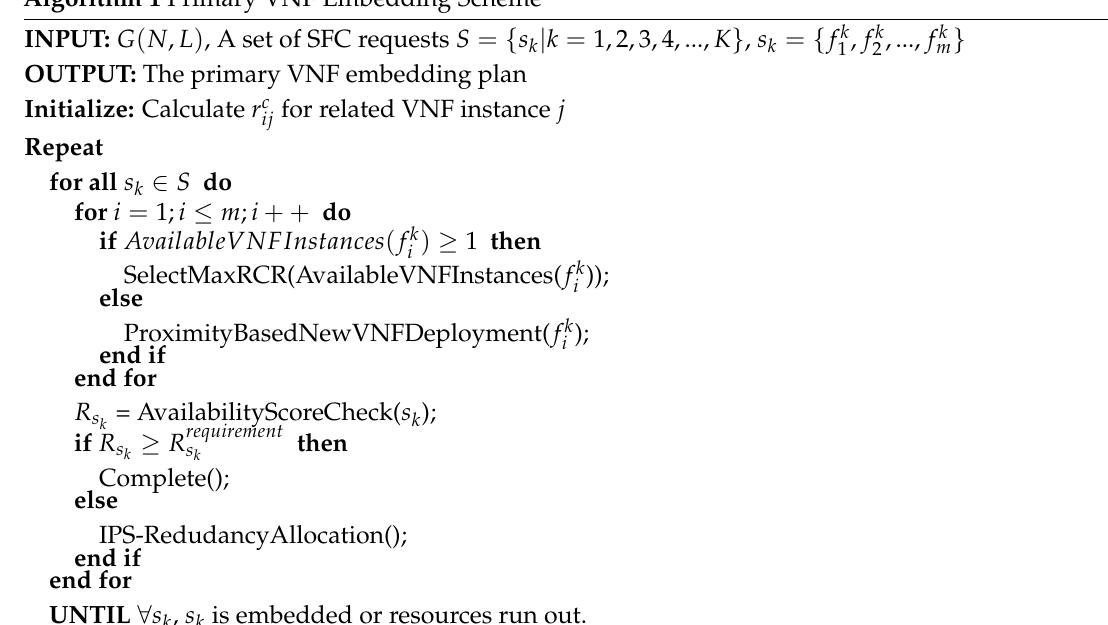
Algorithm 1 Primary VNF Embedding